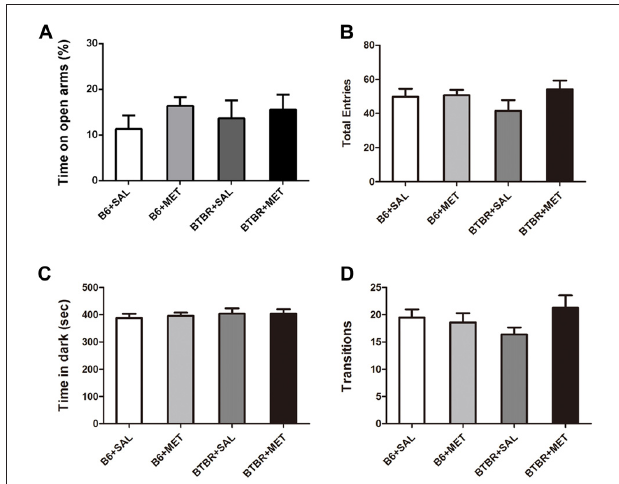
FIGURE 6 | Early metformin treatment did not induce anxiety-like effects in the EPM and standard light-dark transitions. (A) Early metformin treatment didn’t alter the percent of time in open arms in B6 and BTBR mice. (B) The total entries in B6 and BTBR mice were not affected by early metformin treatment. (C) Early metformin treatment didn’t change time spent in dark box in B6 and BTBR mice. (D) Number of transitions between the light and dark compartments exhibited identical scores in all groups. Data are presented as the means ± SEM. n = 10.